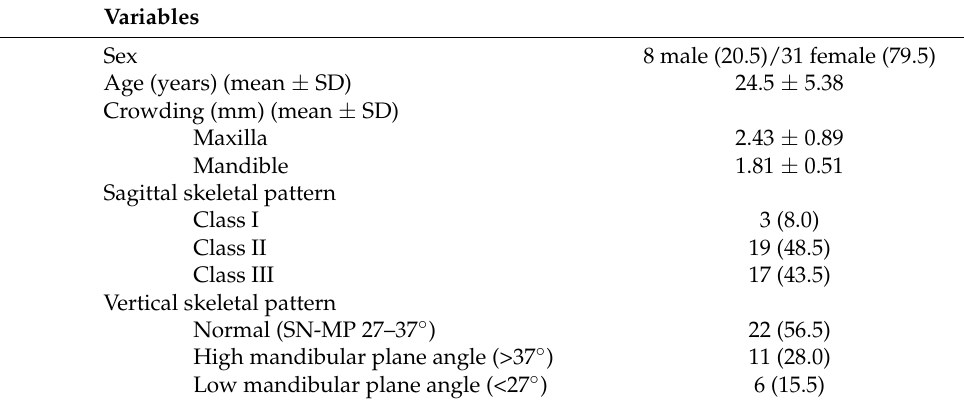
Table 2. Characteristics of